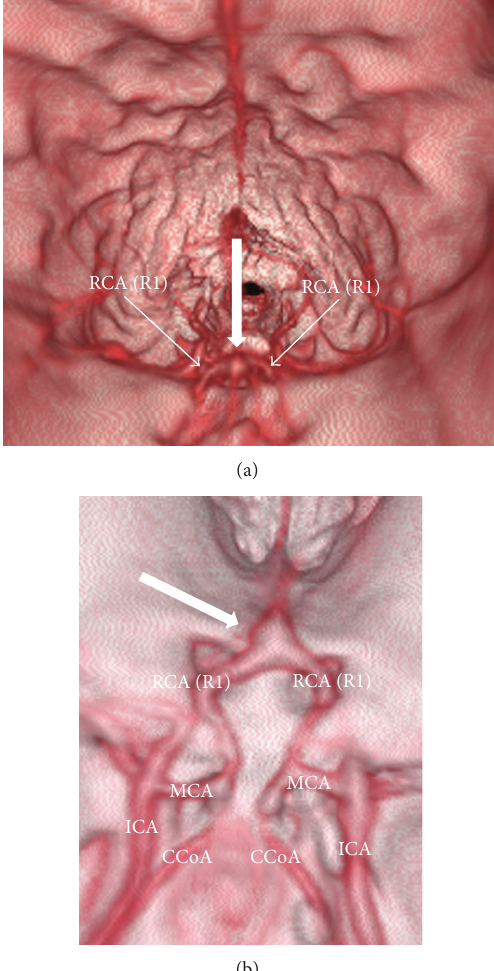
Figure 3: Virtual navigation through the cranial cavity. (a) Forward view,showingthesmallsaccularaneurysmatthejoiningpointofthe two pre-joining segments (R1) of the left and right rostral cerebral arteries. (b) Dorsal backward view of the Circle of Willis showing the small aneurysm (arrow). RCA: rostral cerebral artery; R1: pre- joining segment; MCA: middle cerebral artery; ICA: internal carotid artery; CCoA: caudal communicating artery.